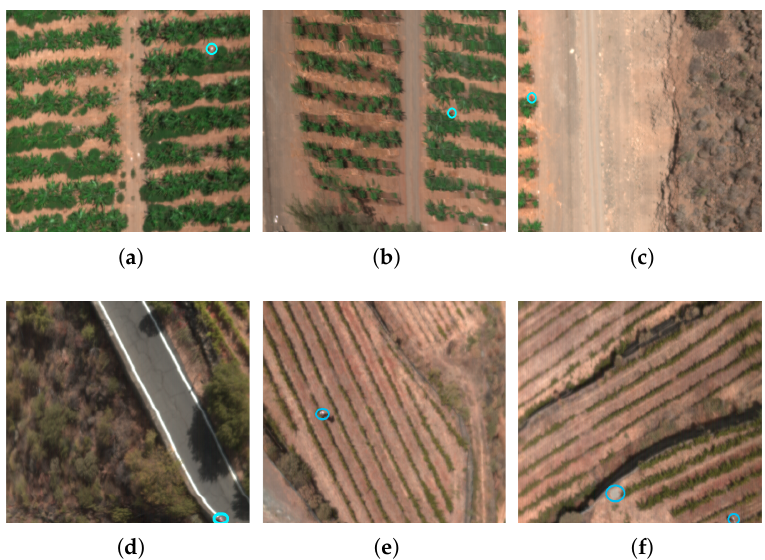
Figure 5. RGB representation of the employed test bench. Pixels enclosed in blue circles represent the anomalous entities to be detected. ( a ) Image 1; ( b ) Image 2; ( c ) Image 3; ( d ) Image 4; ( e ) Image 5; ( f ) Image